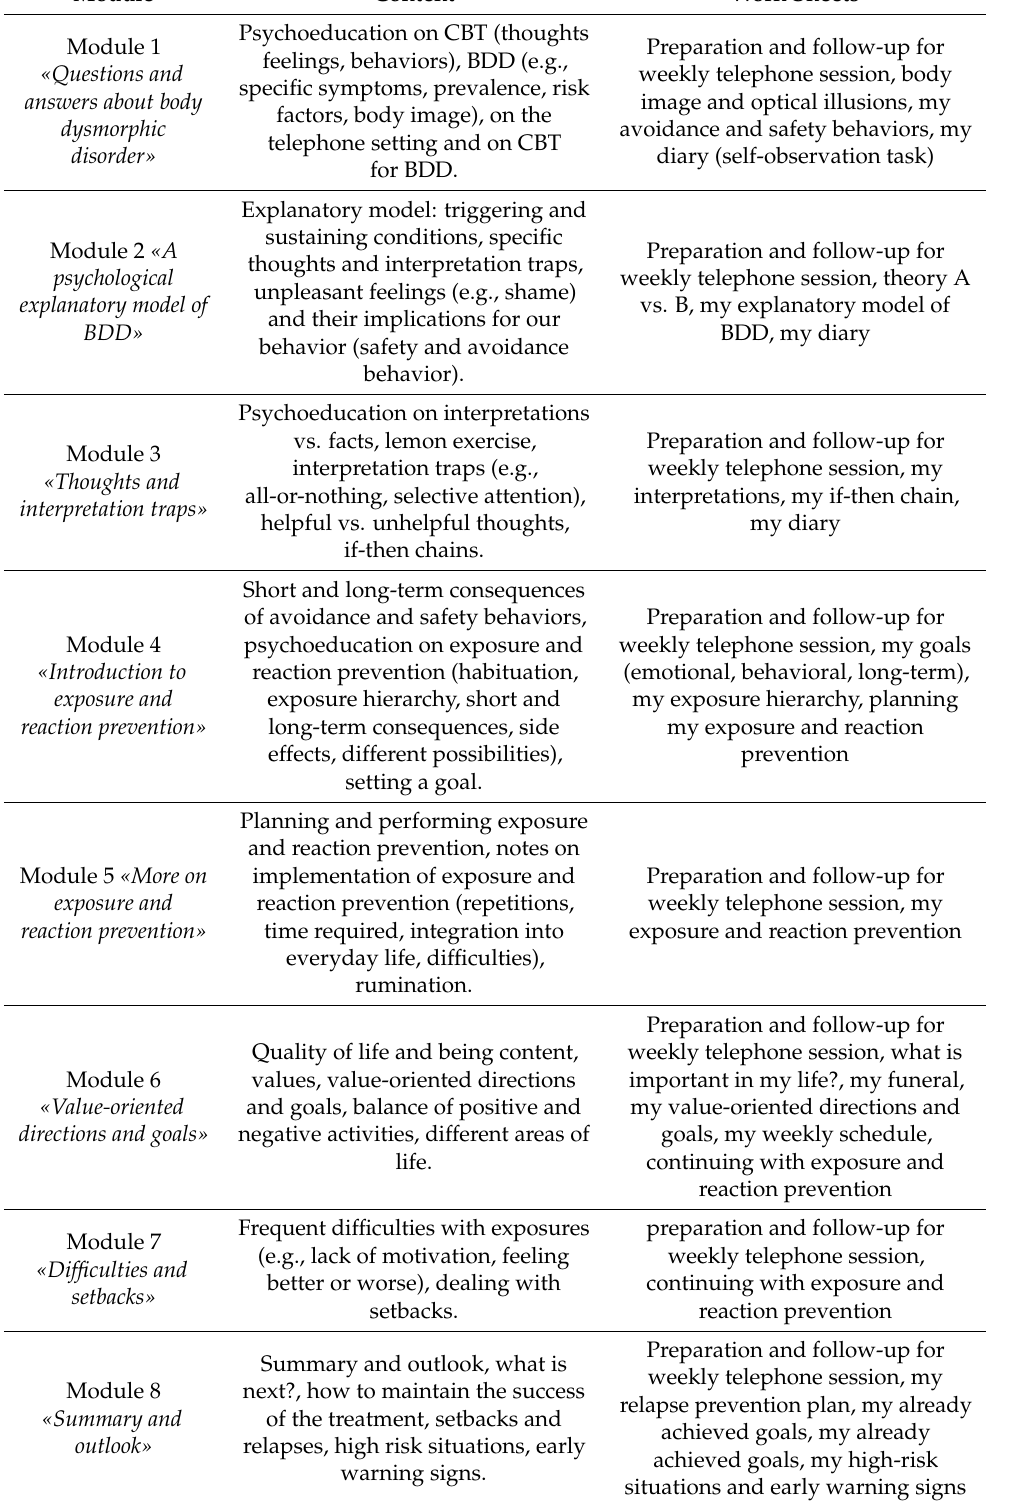
Table 1. Structure and content of BDD-TEL “Being able to live with the